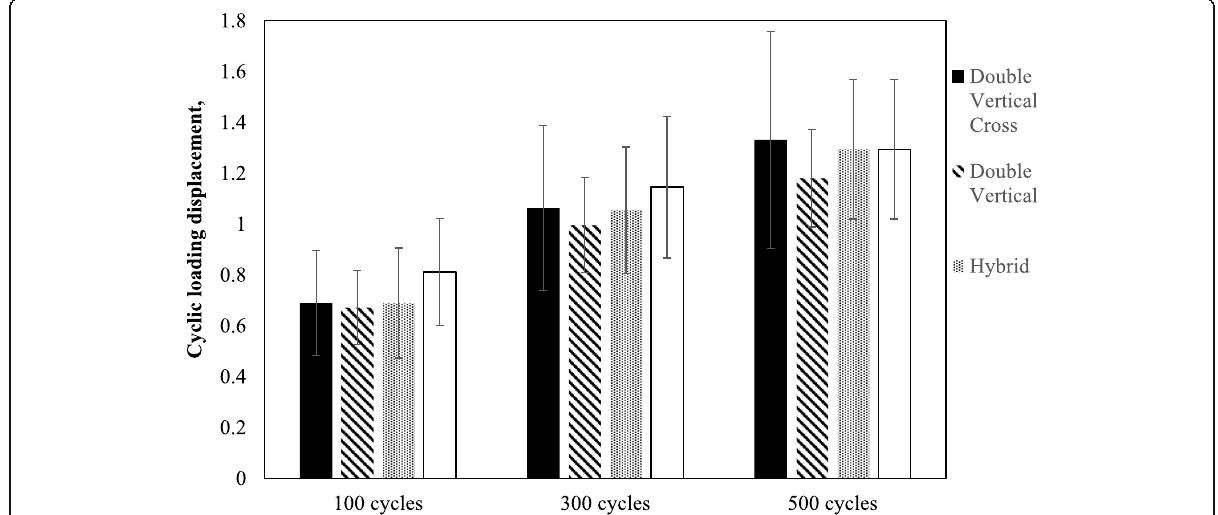
Fig. 5 Displacement after 100, 300, and 500 cycles depicted across four repair